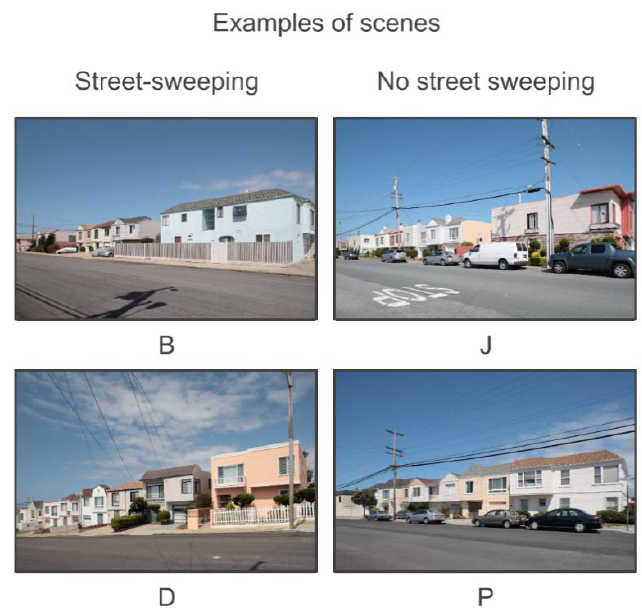
Figure 6. Design features and ranges of options for car vs . no